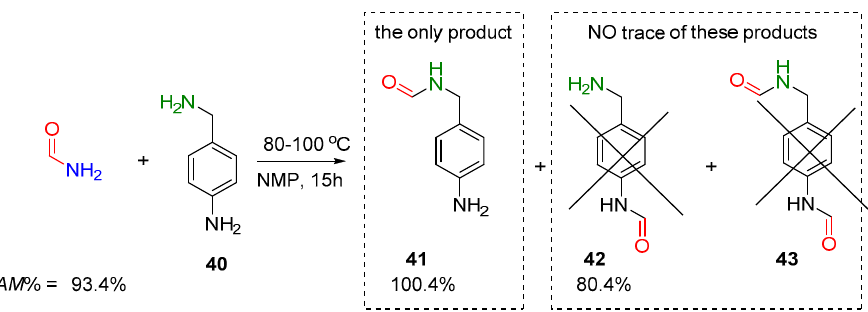
Figure 16. Selectivity of transamidation reaction of N,N -dimethylformamide (DMF) and compound 40 , having two types of amino groups. The three possible products 41 – 43 are shown. The corresponding amidicity values were computed at B3LYP/6-31G(d,p) level of theory.